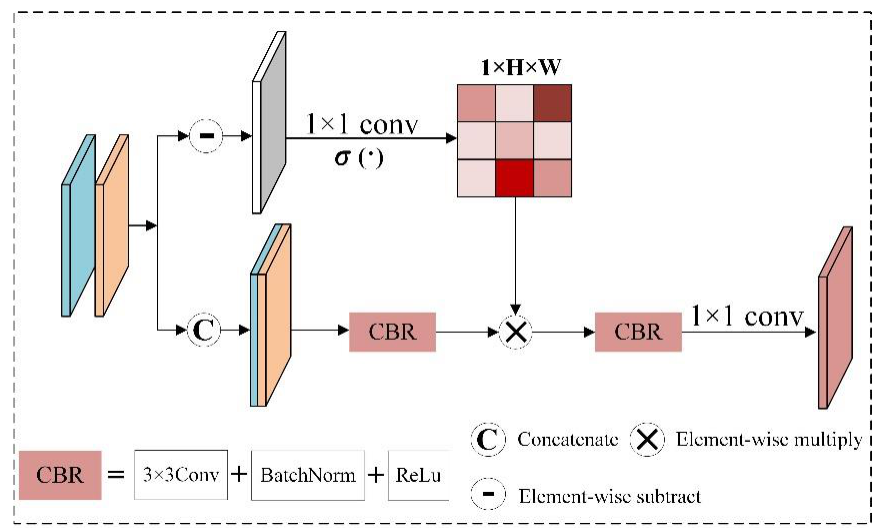
Figure 2. Overview of the FDE module. The proposed FDE module has difference and concatenation branches. The former applies the sigmoid activation function to obtain the feature difference attention map after making a difference on bitemporal feature maps, whereas the latter element-wise multiplies the attention map and the concatenated features to enhance the difference. The feature maps of the four scales are operated in the same way.